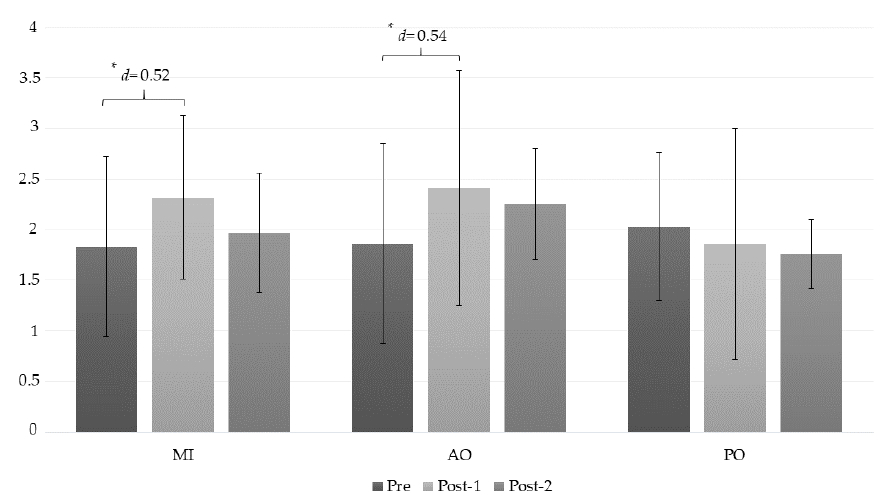
Figure 4. Changes in the PPT right trapezius measurement. *: p < 0.05; AO: action observation; MI: motor imagery group; PO: placebo observation group; Pre: pre-intervention measurement; Post-1: first post intervention measurement (immediately after intervention); Post-2: second post intervention measurement (10 min after intervention).